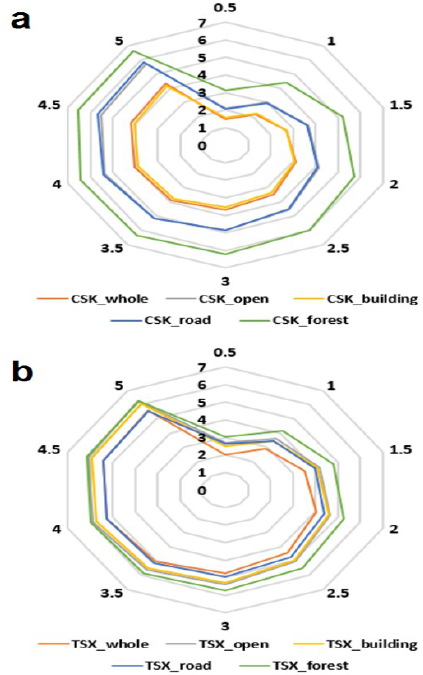
Figure 6. Relative vertical accuracies (0-7m) of DSMs for different land forms (CSK= a; TSX= b; distances from 1 st to 10 th pixel=